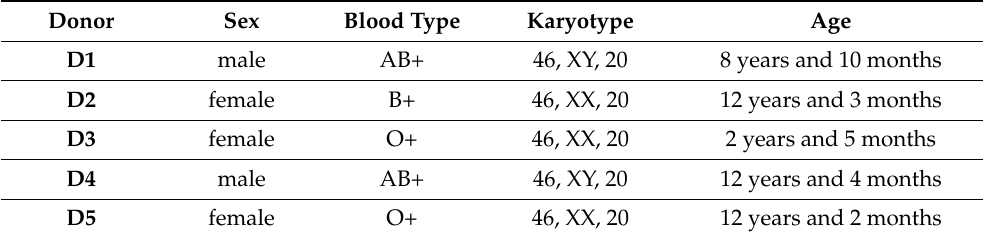
Table 2. The main characteristics of BM-MSCs donors enrolled in the